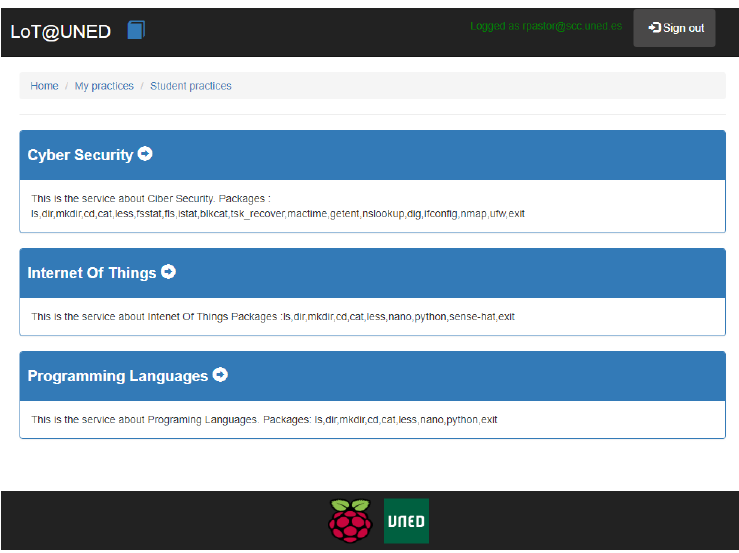
Figure 6. Knowledge domain for IoT supported learning scenarios.